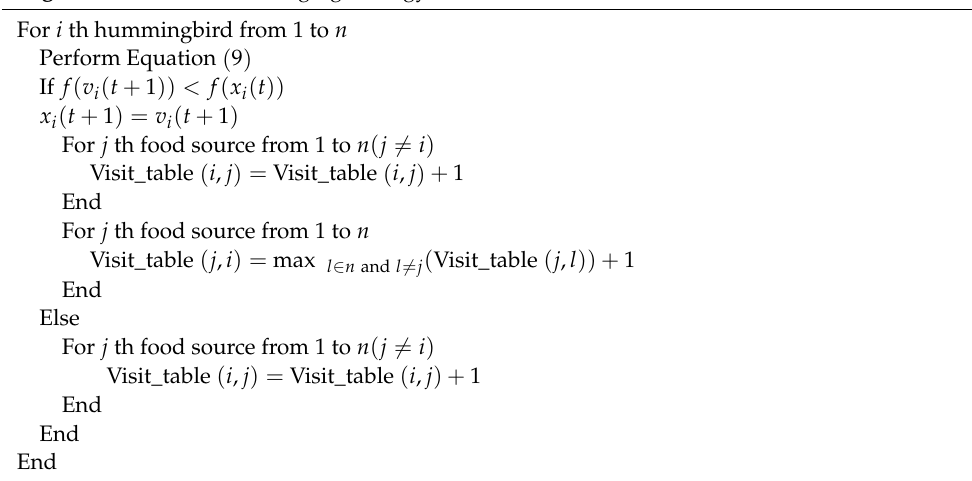
Algorithm 3: Territorial foraging strategy of AHA.